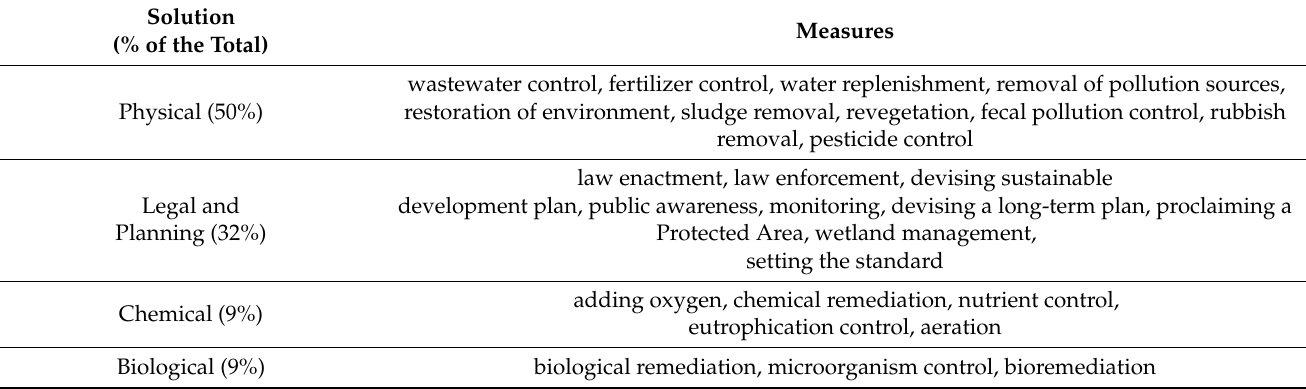
Table 4. Final solutions and measures recommended by